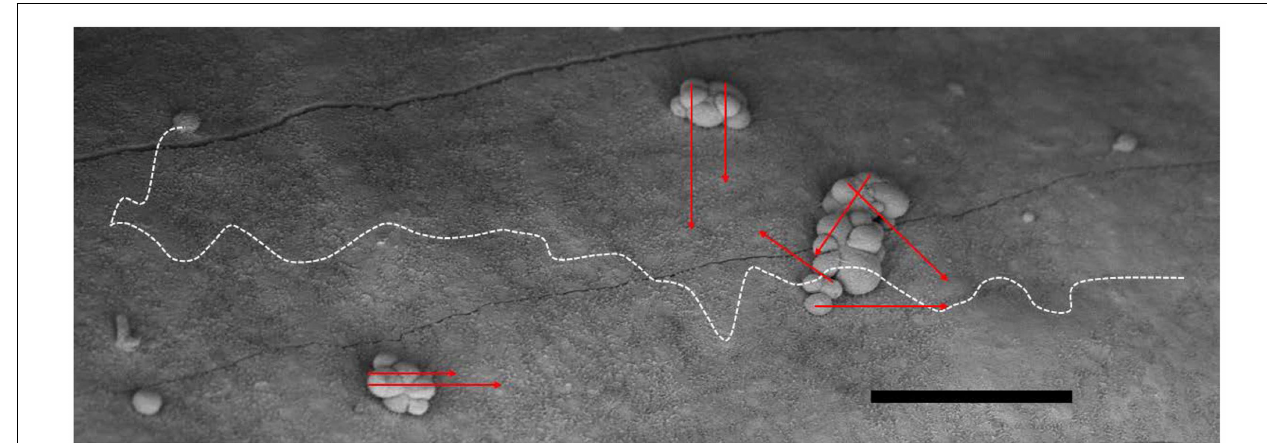
and its sub-layer.They cannot reach the epithelial cells of the intestinal lining.The situation for β − particles on the other hand, shows that a great deal of its energy will be deposited far away from the binding site and possibly into healthy tissue as demonstrated by the white dashed line (here ~700 µ m). Consequently, it may add to side effects. Bar equals 100 µ